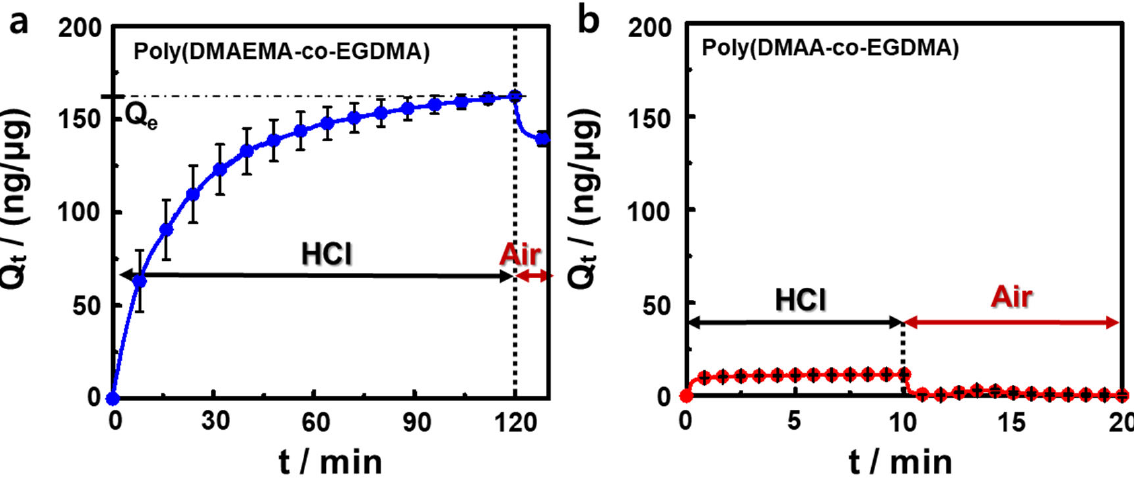
Figure 2. Binding capacity ( Q t ) as a function of time for ( a ) poly(DMAEMA ‐ co ‐ EGDMA) and ( b ) poly(DMAA ‐ co ‐ EGDMA) films in 70 ‐ ppm HCl, and synthetic air flow at 22 °C and 10% RH during the adsorption process. Synthetic air was used for desorption. The adsorption–desorption process was performed until the signal stabilized.